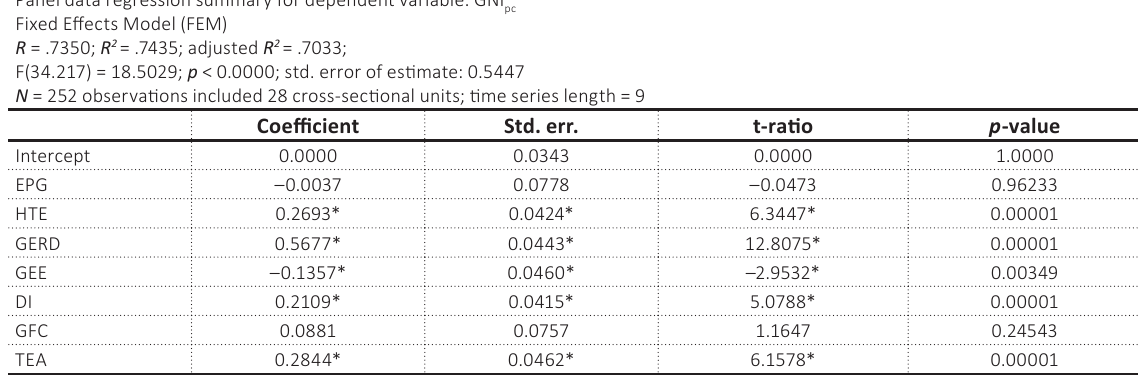
and innovation indicators pc pc